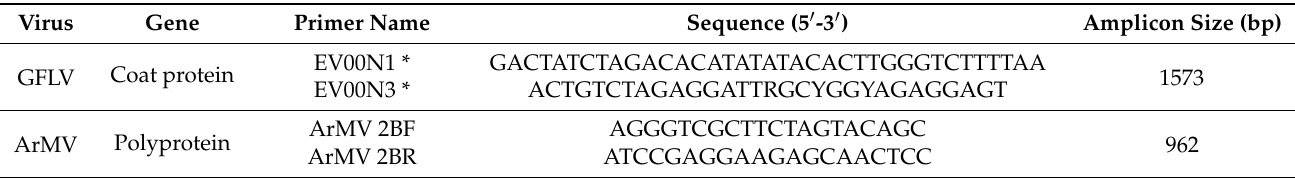
Table 2. Primers list used for GFLV and ArMV specific detection by end point RT-PCR and sequencing. Virus